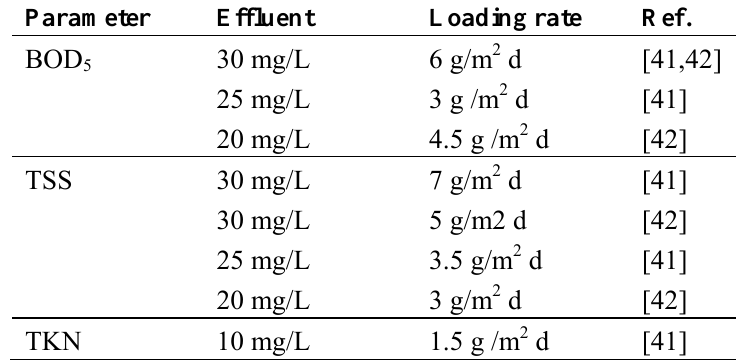
Table 2. Loading rates recommended for achieving target effluent concentration in FWS